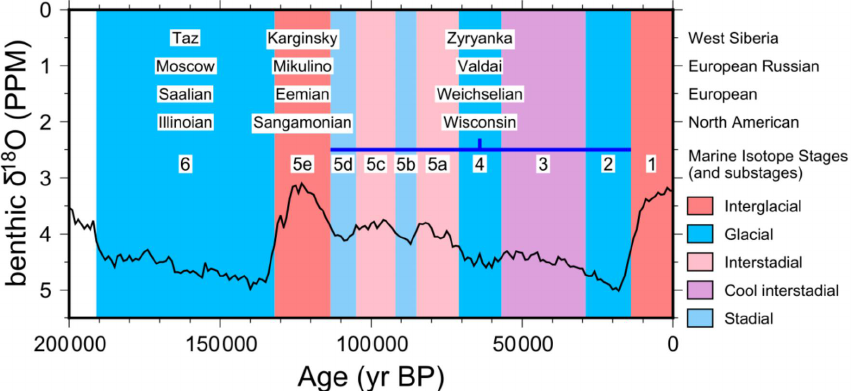
Figure 2. The timescales covered in this paper, along with regional nomenclature. The benthic δ 18 O curve is the LR04 stack, from which the marine isotope stages are derived (Lisiecki and Raymo,